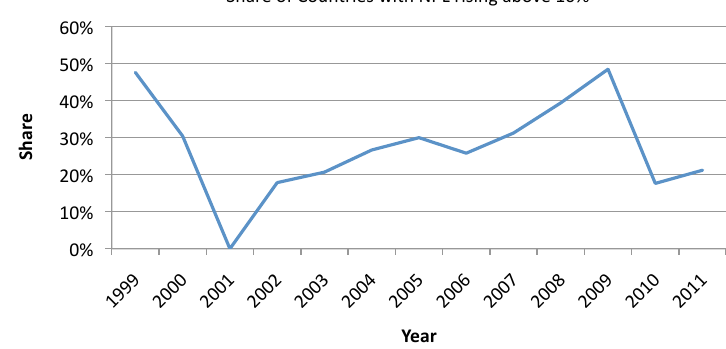
Figure 1: Share of countries in the sample with rising NPL, per